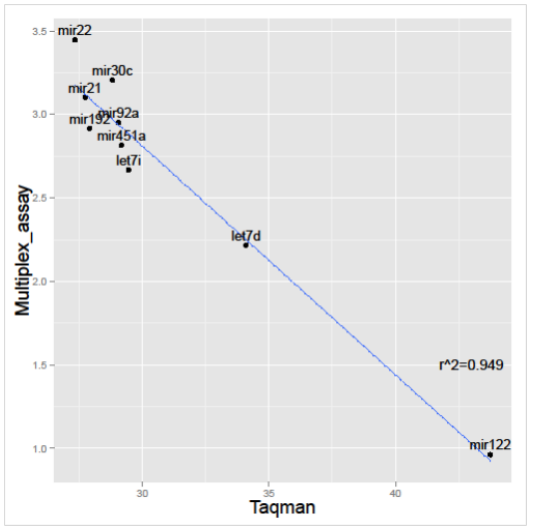
Figure 5. Correlation between signal intensity (Log 10 transformed) achieved by multiplex miRNA assay and C t values obtained by Taqman qPCR, using the same RNAs.